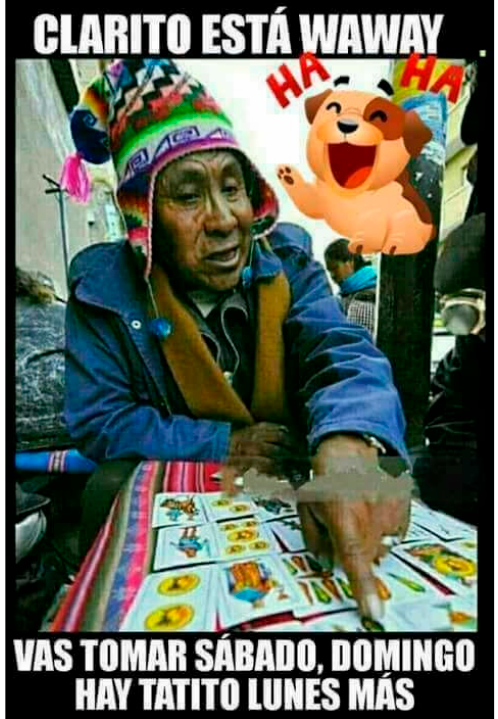
Figure 3. It’s evident my dear